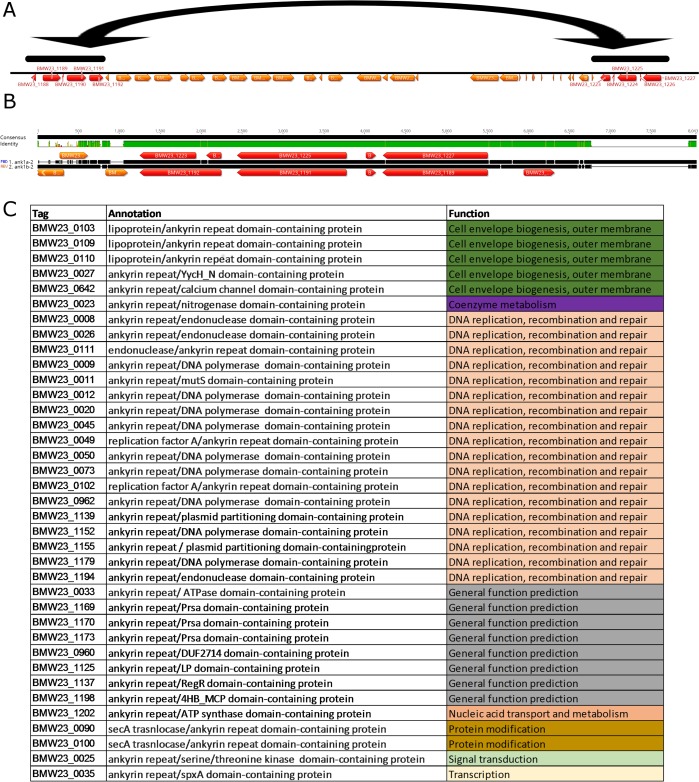
Ankyrin repeat domain-containing proteins.(A) Location of recently duplicated region in the 3’ end of the genome (highlighted in black bars, duplicated CDS in red) (B) Alignment of recently duplicated sequence from A, encoding several Ankyrin repeat domain-containing proteins. A region containing four CDS was duplicated in a reverse complement orientation maintaining the integrity and sequence identity of the original sequence (% DNA ID in the central region is 99.7%) (C) ID, annotation and functional class of ankyrin repeat domain-containing proteins with a recognizable domain fragment in the N-terminal region of the protein.